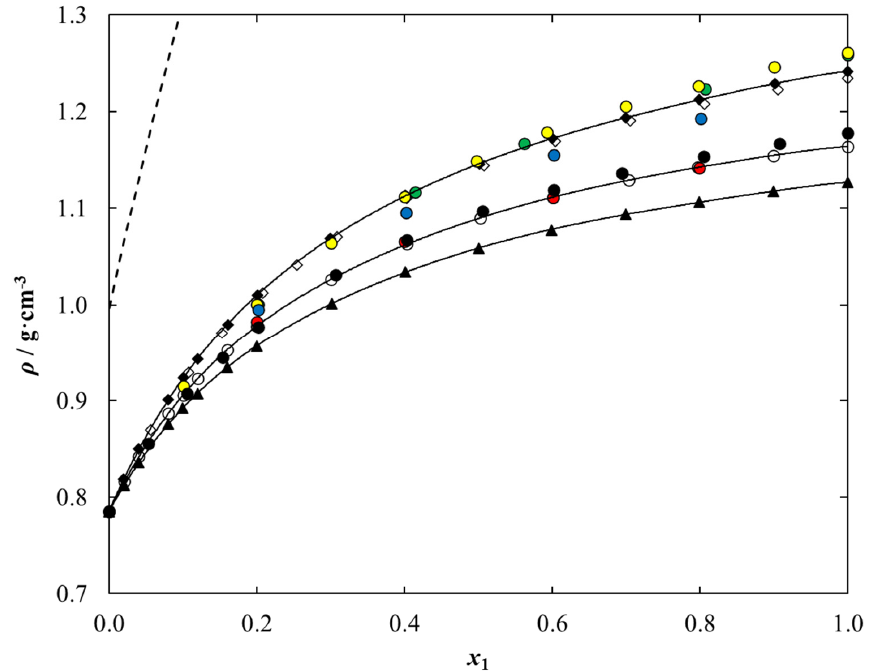
Figure 5. Experimental and calculated liquid density data of {Dimethyl Phosphate-Based IL (1) + Ethanol (2)} system vs. ionic liquid mole fraction, x 1 , at T = 298.15 K: ♦ , [C 1 C 2 MOR][DMP] (this work); ○ , [C 1 C 2 PIP][DMP] (this work); ▲ , [N 1,2,2,2 ][DMP] (this work); ● , [C 1 C 1 IM][DMP] [35]; ● , [C 1 C 2 IM][DMP] [54]; ● , [C 1 C 4 IM][DMP] [49]; ● , [C 1 C 2 PYR][DMP] [41]; ◊ , [C 1 C 2OH PYR][DMP] [41]. Points-experimental, or literature density data; solid lines-calculated using equation (12) with parameters given in Table 10; dashed lines-literature density data for {LiBr (1) + Water (2)} system [55].